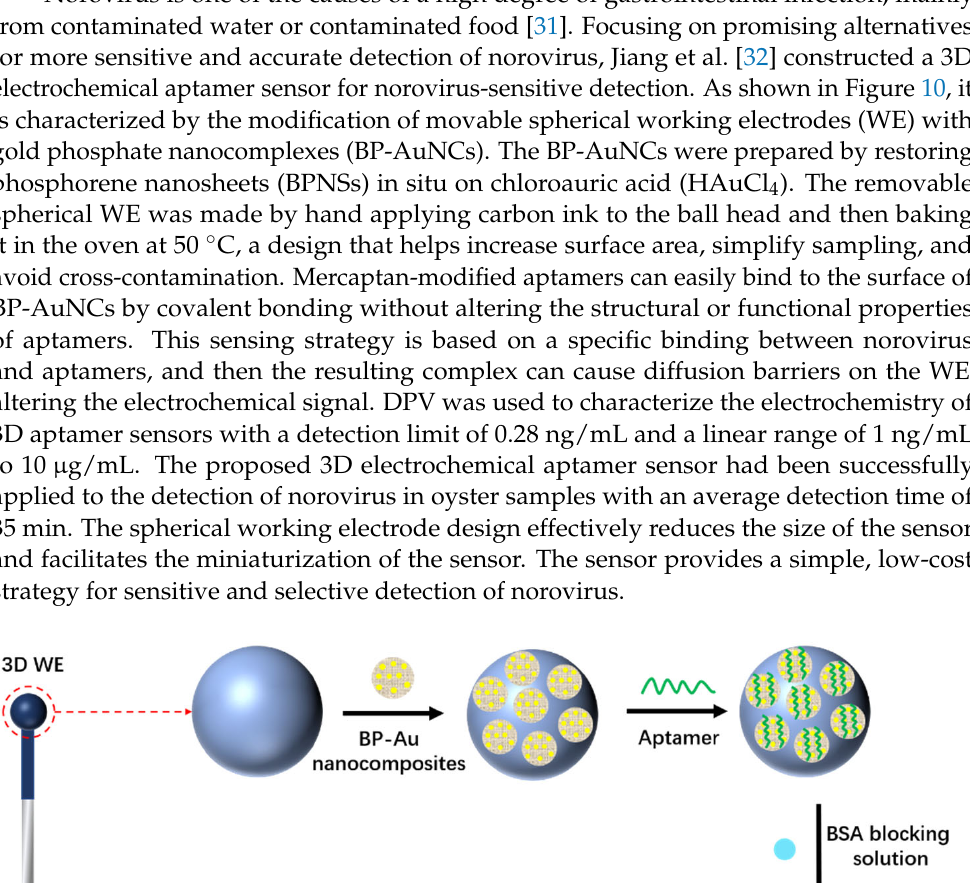
Figure 9. Disposable DNA biosensor constructed by thiol gold coupling of thiolated single-stranded DNA probes (Adapted with permission from Ref. [30]. 2018, Manzano et al.).